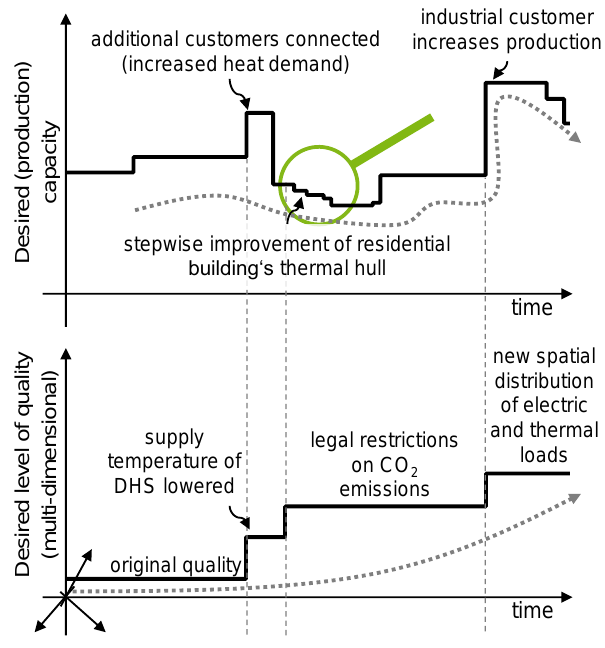
Figure 9. Qualitative difference between pure generation power and the associated quality of supply (deliberately without time and capacity